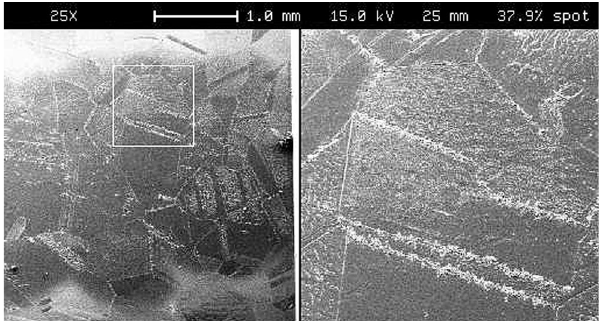
FIG. 23. Detail micrograph of the high-field side of the inner rod of the PBG-E, showing grain boundaries even at the highest- field region. The PBG-E shows significantly less damage than the PBG-R